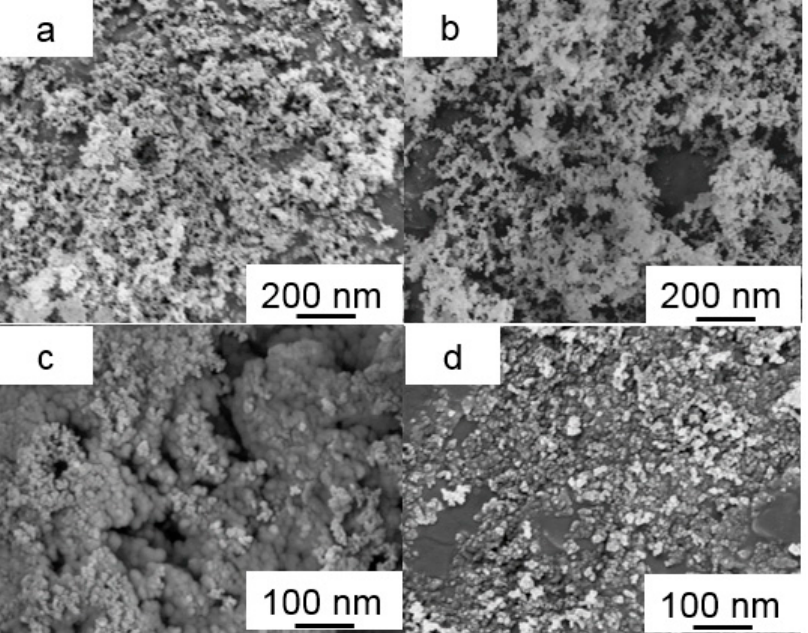
Figure 5. SEM images of SiO 2 aerogel ( a ) and M-SiO 2 aerogel ( b ), SiO 2 aerogel-based phase change materials (PCMs) ( c ) and M-SiO 2 aerogel-based PCMs ( d ).